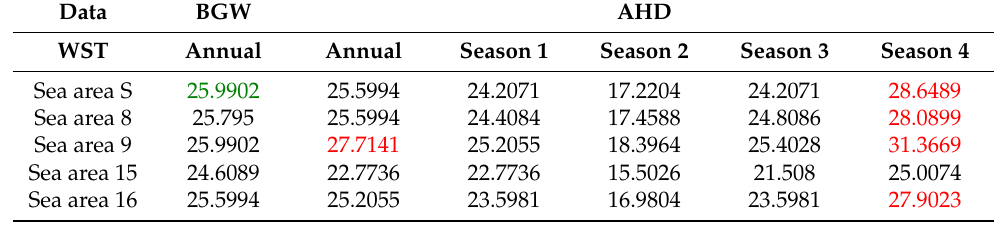
Table 9. Mean wind speed (m/s) corresponding to significant wave height estimated in Table 8.